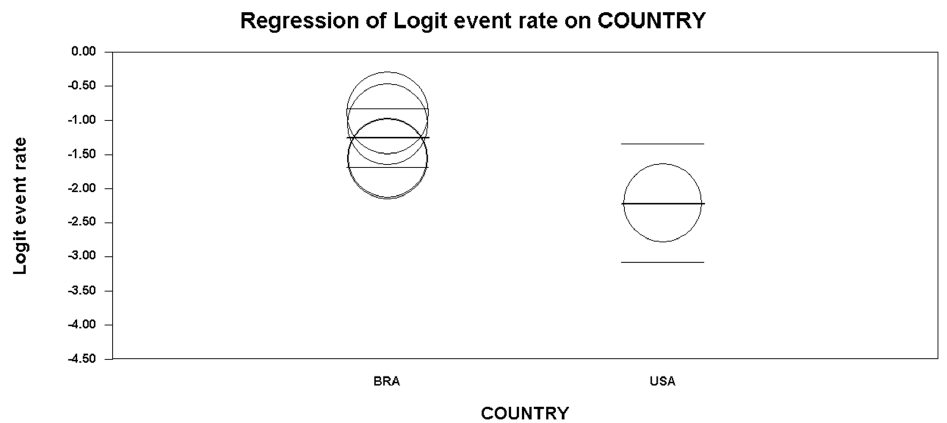
Figure 3. Meta-regression analysis showing statistically significant different binge drinking patterns in Brazil (BRA) and in the United States (USA), among truck-drivers.